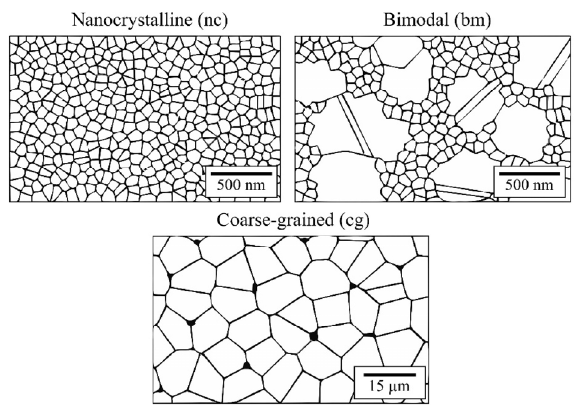
Fig. 1 Schematic representation of the three different evaluated microstructures.